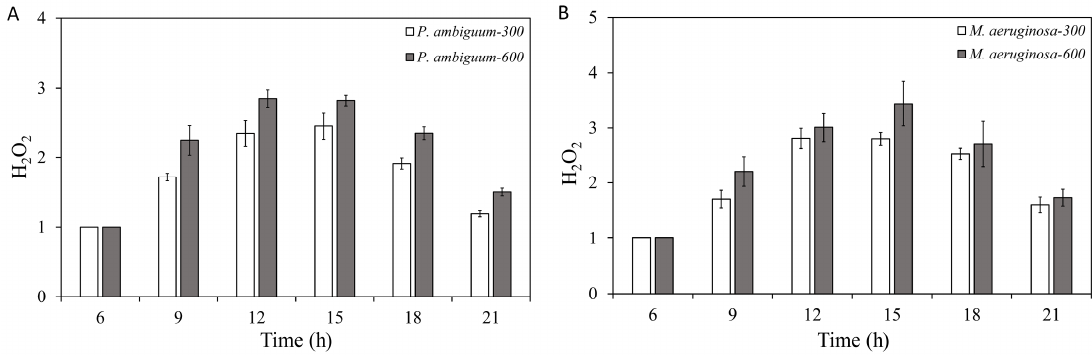
Figure 1. Diurnal variations in the H 2 O 2 contents of Phormidium. ambiguum (strain NIES 2119) ( A ) and Microcystis aeruginosa (strain NIES 111) ( B ). The numbers 300 and 600 represent the maximum photosynthetically active radiation (PAR) intensities (in µ mol·m −2 ·s −1 ) for two different treatment conditions, where the maximum PAR intensity was reached at 12:00 h. The error bars represent the standard deviations.